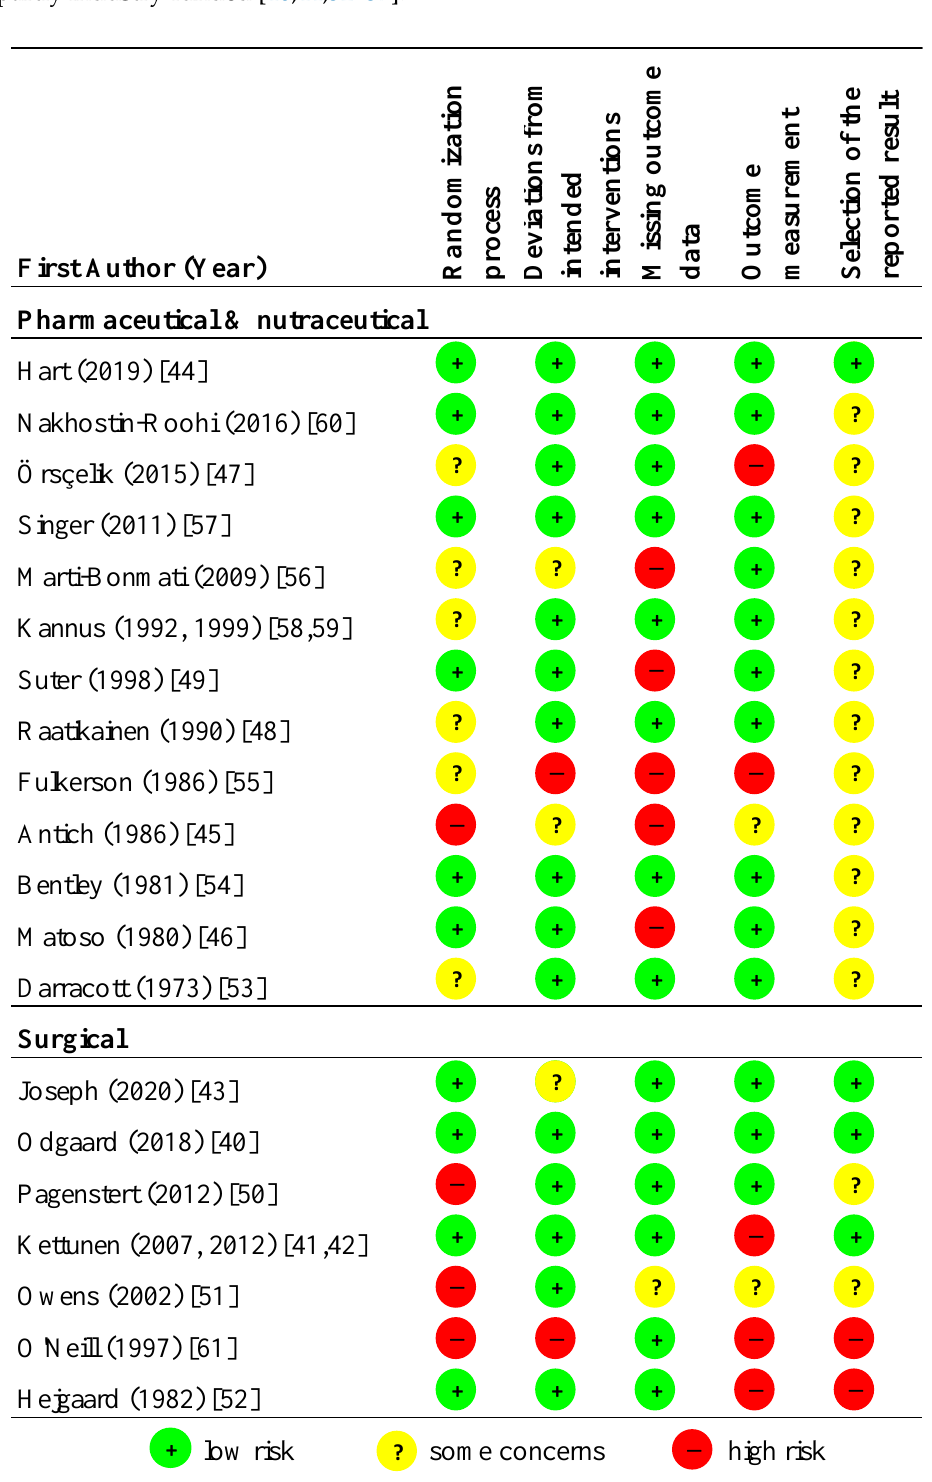
Figure 2. Risk of bias (RoB) summary. Where more than one manuscript of the same study is published, they are reported together.